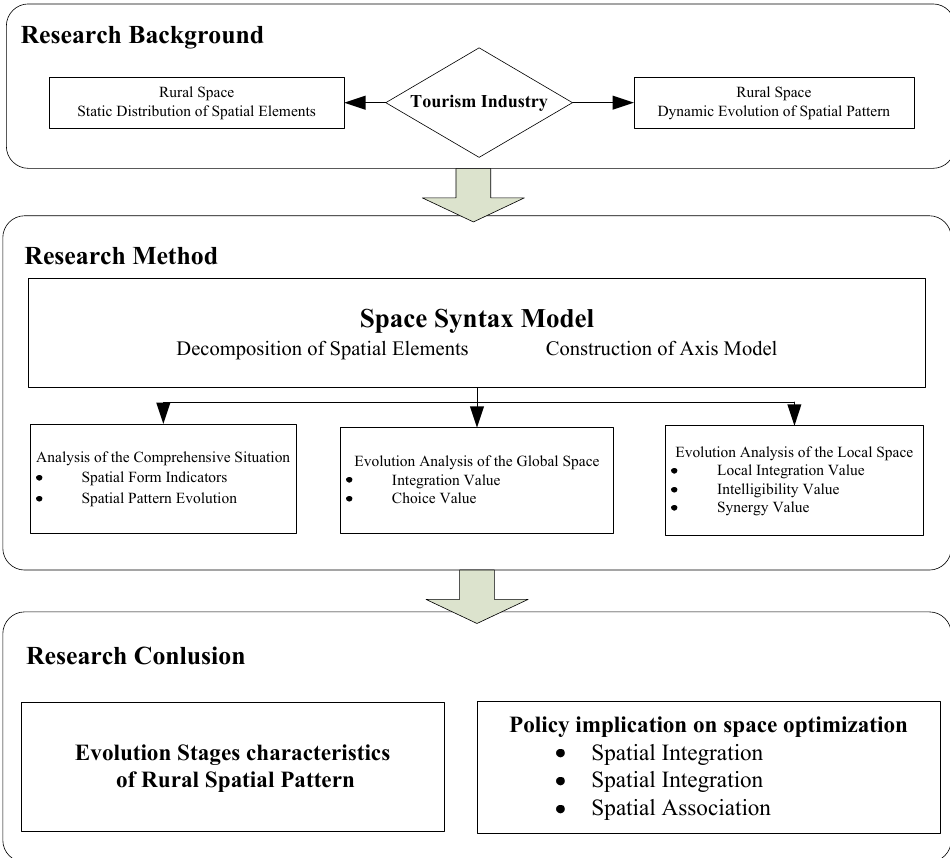
Figure 2. Research route.